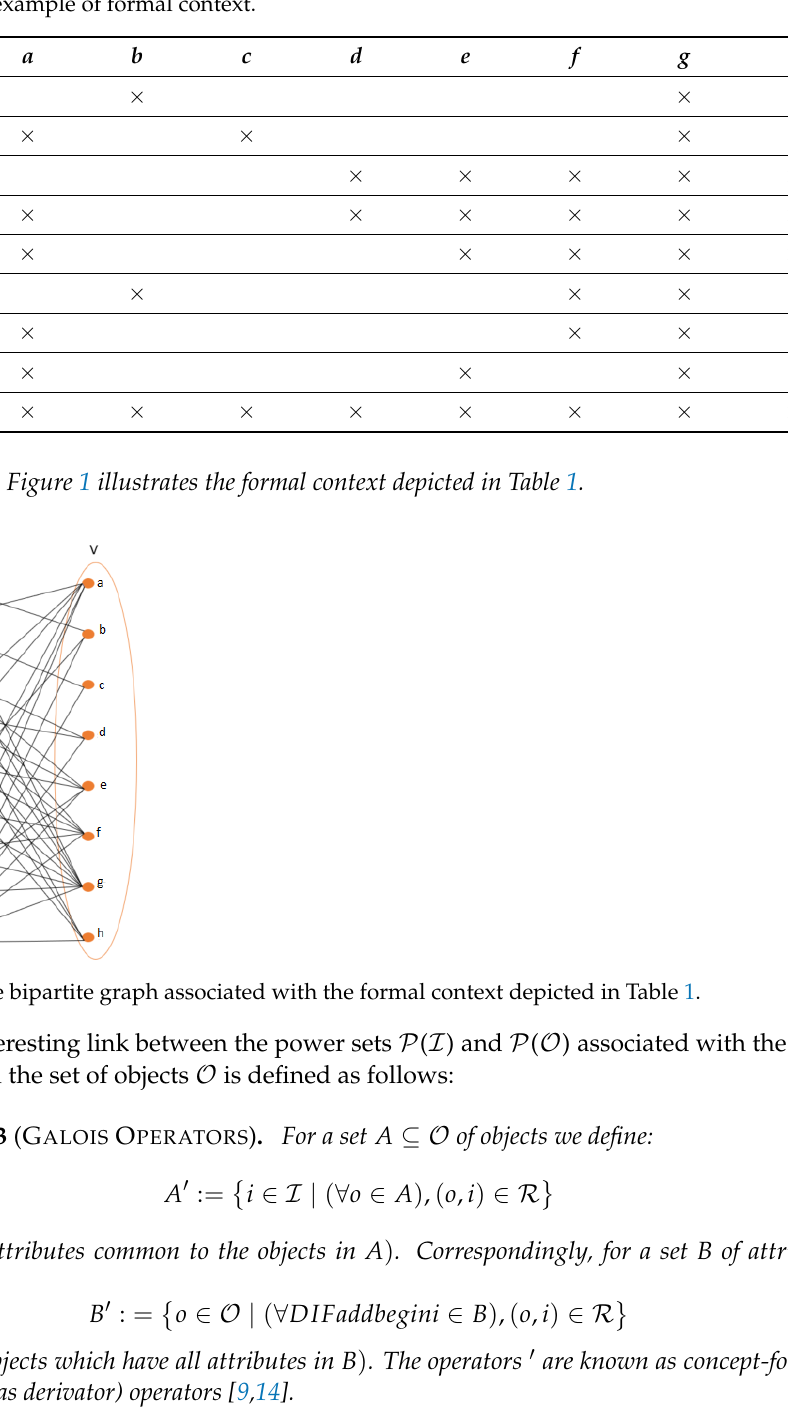
Table 1. An example of formal context.